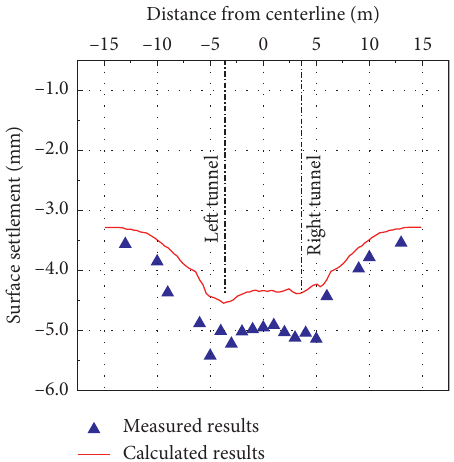
Figure 6: Comparison between calculated and measured surface settlement at G